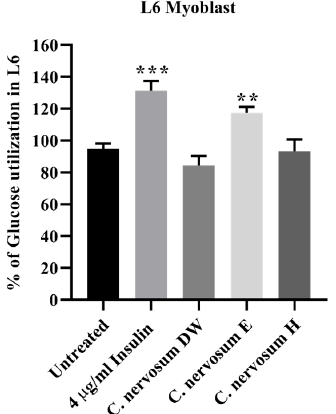
Figure 4. Effect of C. nervosum extracts on glucose utilization in L6 myoblasts. Cells were treated for 48 h. Data are mean ± SD of four independent experiments. *** p < 0.001, ** p < 0.01 versus the untreated control.